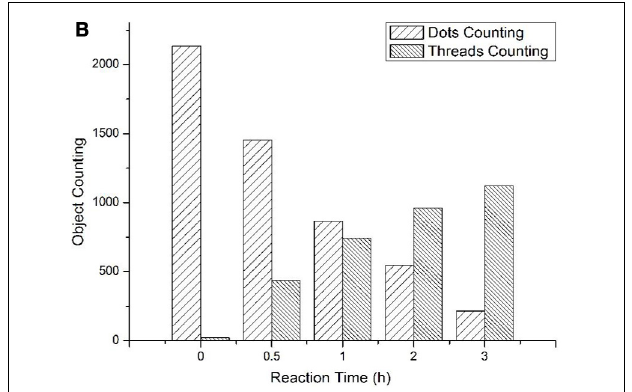
Figure 3B | Products of the molecular machine when different reaction time. (A) TIRFM visualization. (a) 0.5h, (b) 1.0h (c) 2.0h (d) 3.0h; (B) Counting results of the dots and thread-like